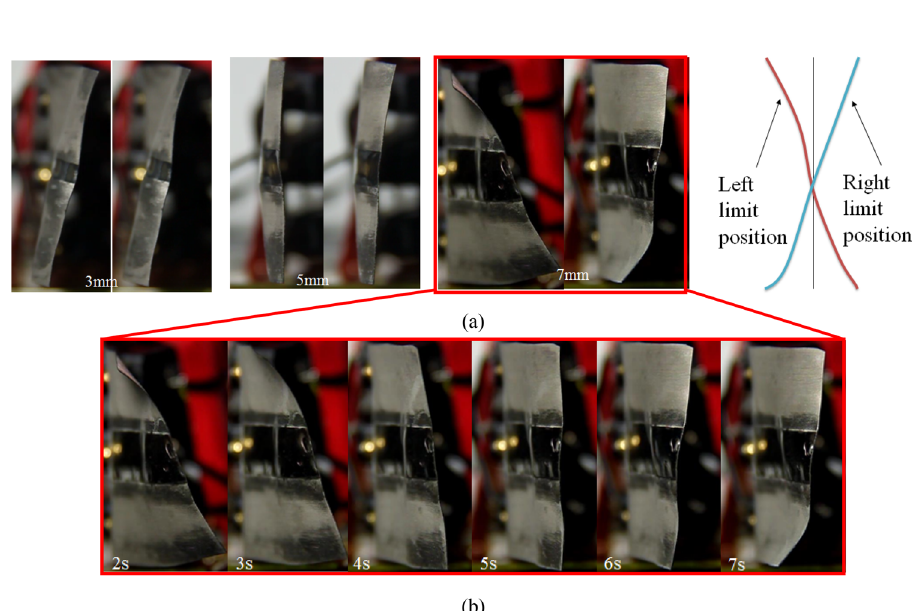
Figure 3. The limit position of IPMCs under AC voltage drive. ( a ) Different electrode separation under 3 V 0.1 Hz. ( b ) Twisting motion at different